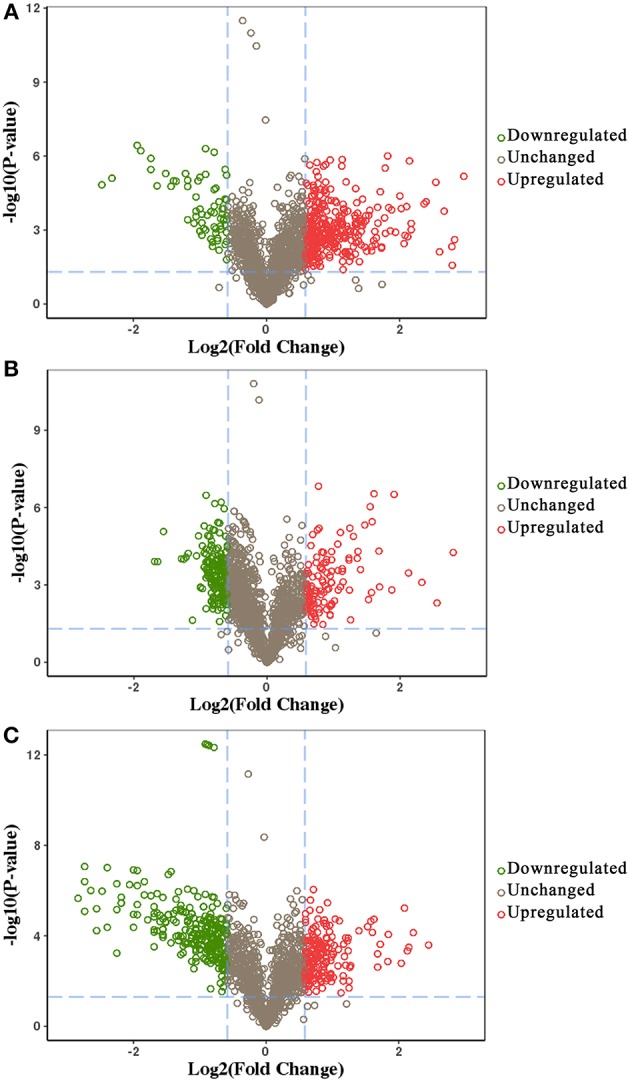
Volcano plots showing the median phosphopeptides log2 fold change plotted against the –log10
P-value. The results highlight the phosphopeptides up/down-regulated in RH strain when comparing RH/PRU strains (A), in PRU when comparing PRU/PYS strains (B), and in PYS strain when comparing PYS/RH strains (C), respectively. Red and green circles represent upregulated and downregulated DEPs, respectively. Dotted lines indicate (±) 1.5-fold change.